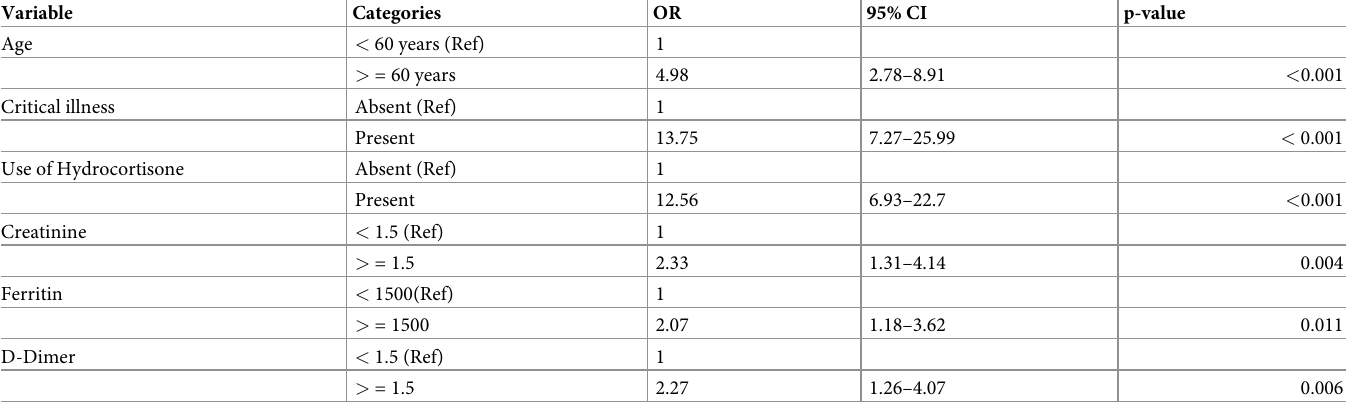
Table 2. Multivariable logistic regression model for factors associated with in-hospital